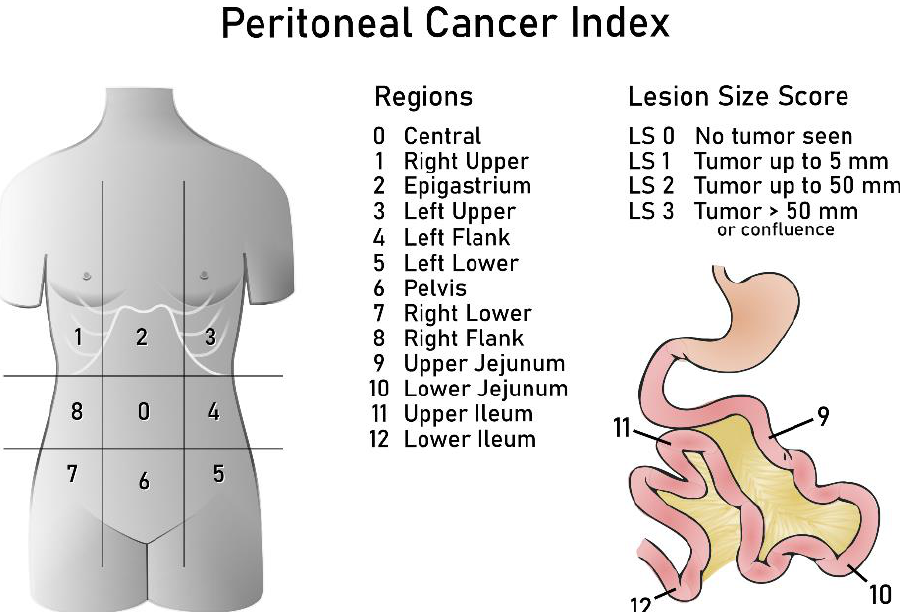
Figure 3. Peritoneal cancer index.